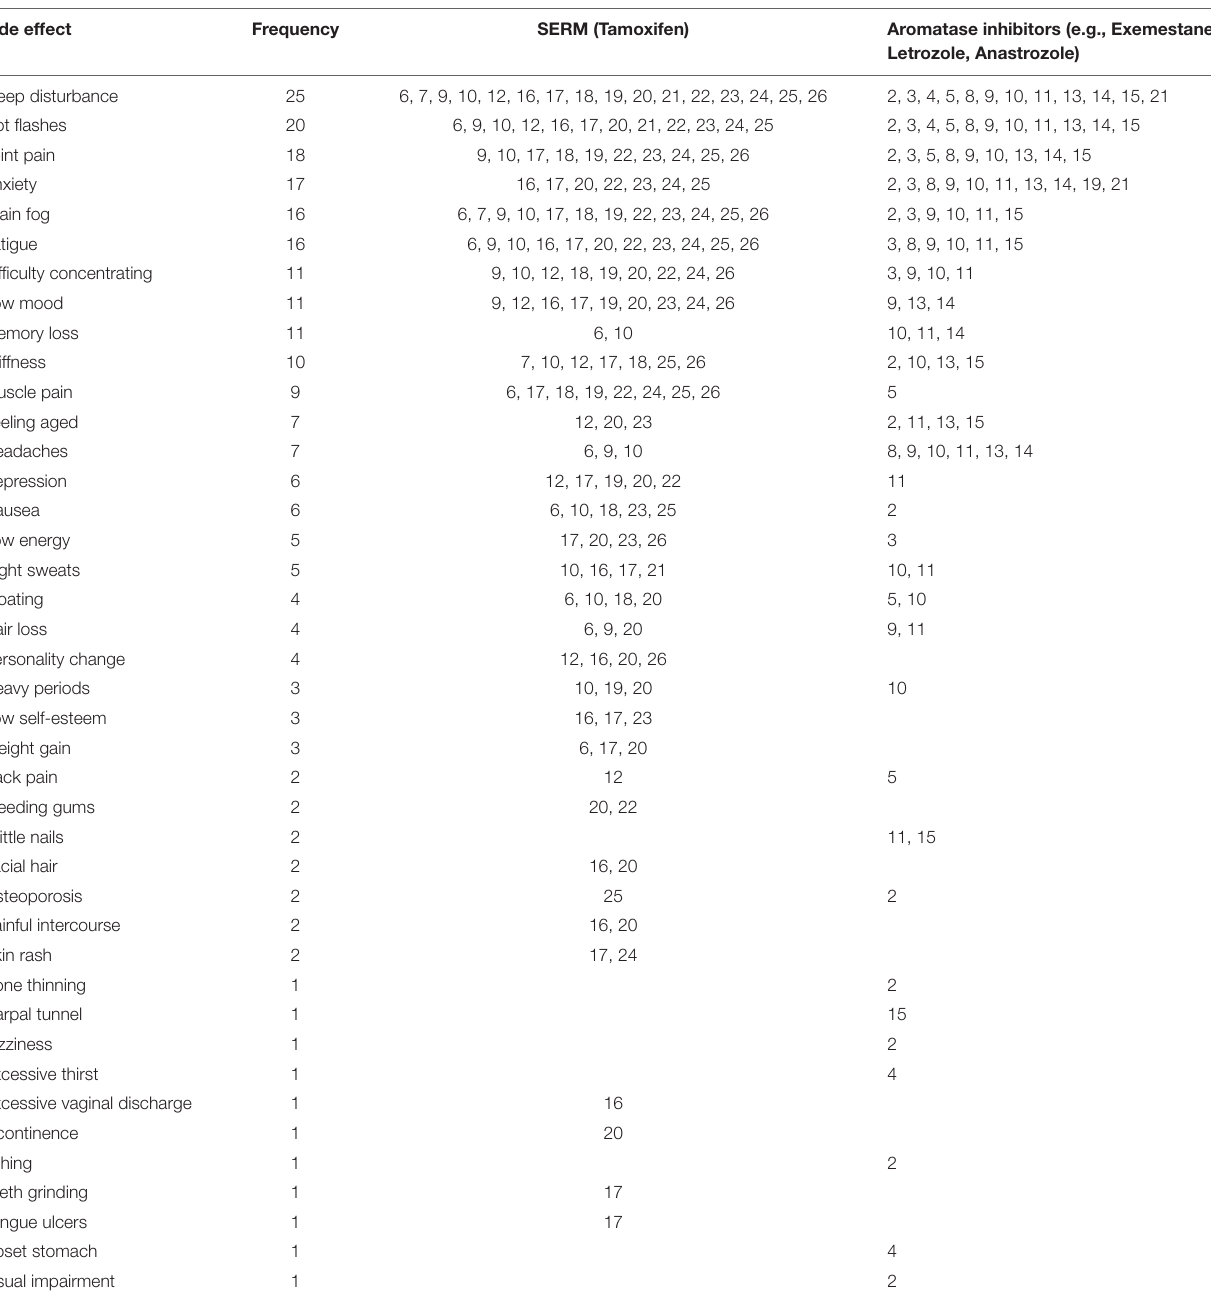
TABLE 1 | Frequency of reported HT side